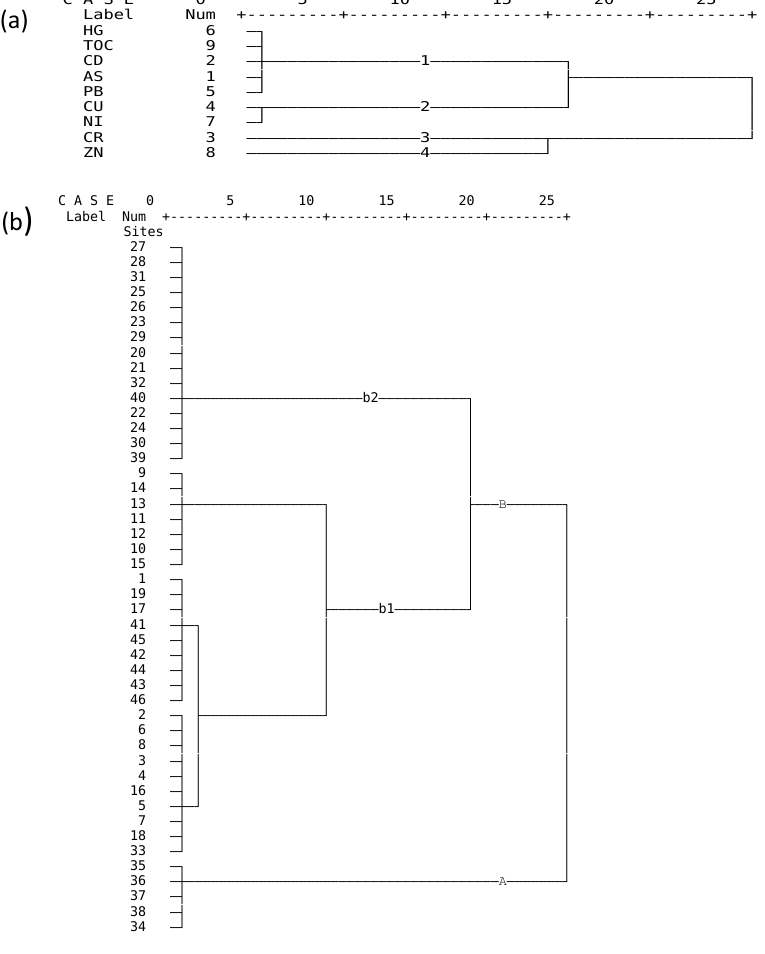
Figure 3. Dendrogram of the rescaled distance cluster combination of the variables ( a ) and the sampling sites based on similarity ( b ) using the Ward method.